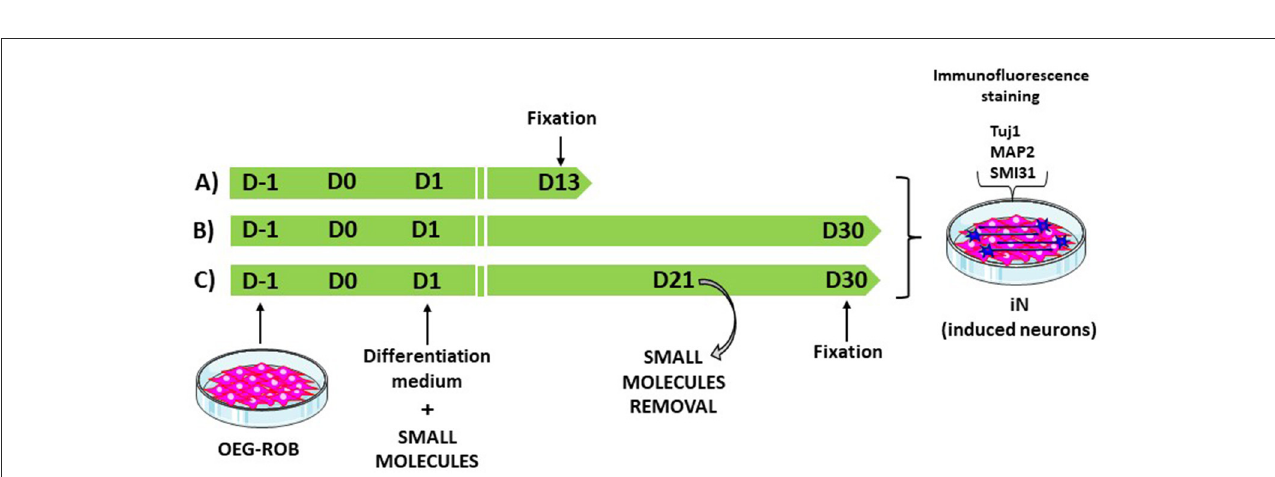
FIGURE3 OEG-ROB reprogramming workflow. To induce reprogramming, small molecules were added to the differentiation medium from the first day of induction (D1) and were maintained until the end of the trial, 13 days (D13) or 30 days (D30) post induction (A, B) . In (C) , small molecules were removed at day 21 (D21) of the reprogramming process and OEG-ROB were left in differentiation medium for further maturation until day 30 (D30). Neuronal induction was assessed via expression of neuronal markers Tuj1, MAP2, and